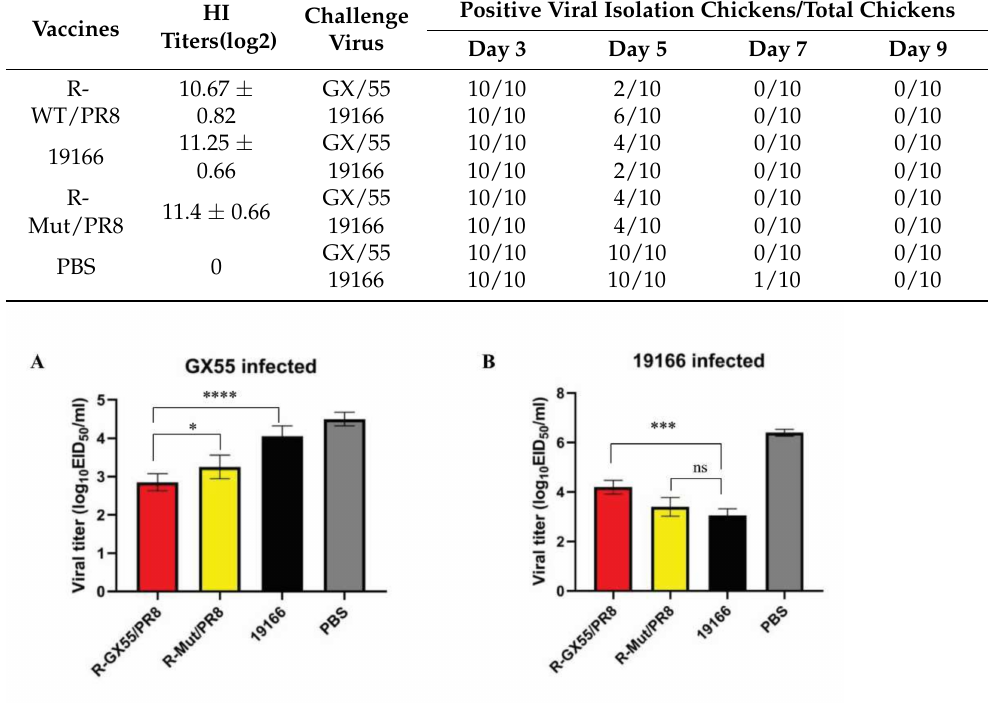
Figure 4. Protective efficacy of R-Mut/PR8 virus. 3-week-old SPF chickens were immunized with inactivated vaccines (0.4 mL/chicken). Three weeks post-vaccination, each chicken in different groups was intranasally injected with 10 6 TCID 50 of the H9N2 virus. The samples collected at 3 days post infection (dpi) were titrated by the 50% infectious egg dose (EID 50 ). ( A ): The immune protective efficacy of candidate vaccines against GX55 strain. ( B ): The immune protective efficacy of candidate vaccines against 19166 strain. Statistical differences were labeled according to t-test in GraphPad Prism 8 (ns = not significant, * p < 0.05, *** p < 0.001, **** p <